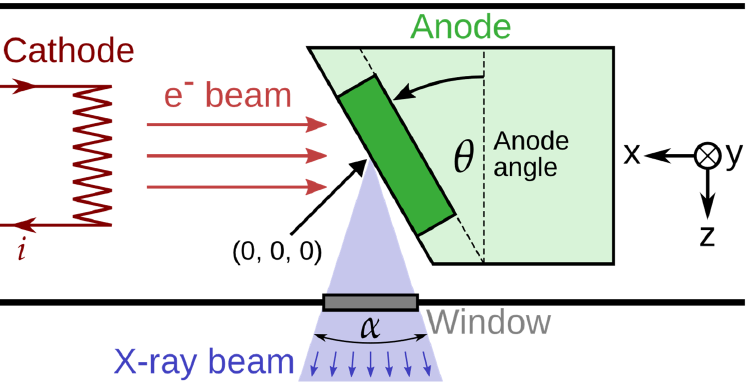
Figure 1. Simplified schematic of a typical X-ray tube and of the coordinate system of this study.